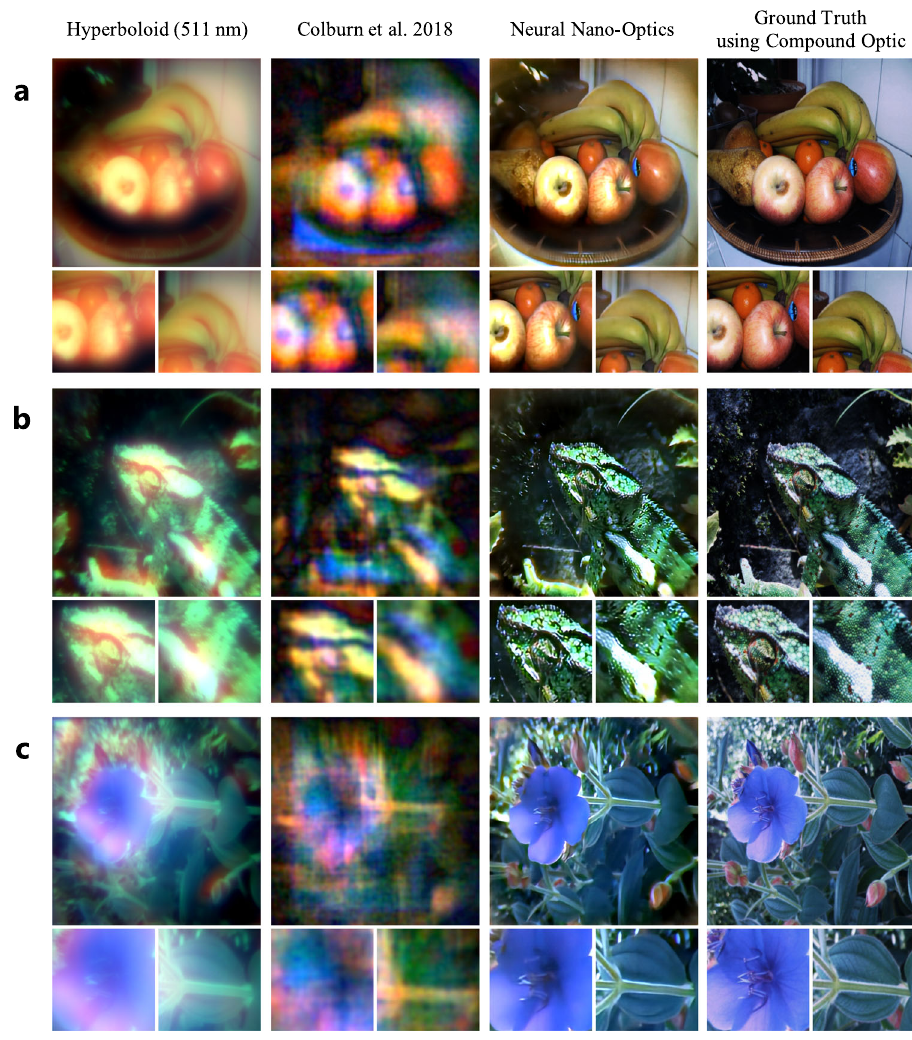
Fig. 2 Experimental imaging results. Compared to existing state-of-the-art designs, the proposed neural nano-optic produces high-quality wide FOV reconstructions corrected for aberrations. Example reconstructions are shown for a still life with fruits in ( a ), a green lizard in ( b ), and a blue fl ower in ( c ). Insets are shown below each row. We compare our reconstructions to ground truth acquisitions using a high-quality, six-element compound refractive optic, and we demonstrate accurate reconstructions even though the volume of our meta-optic is 550,000× lower than that of the compound